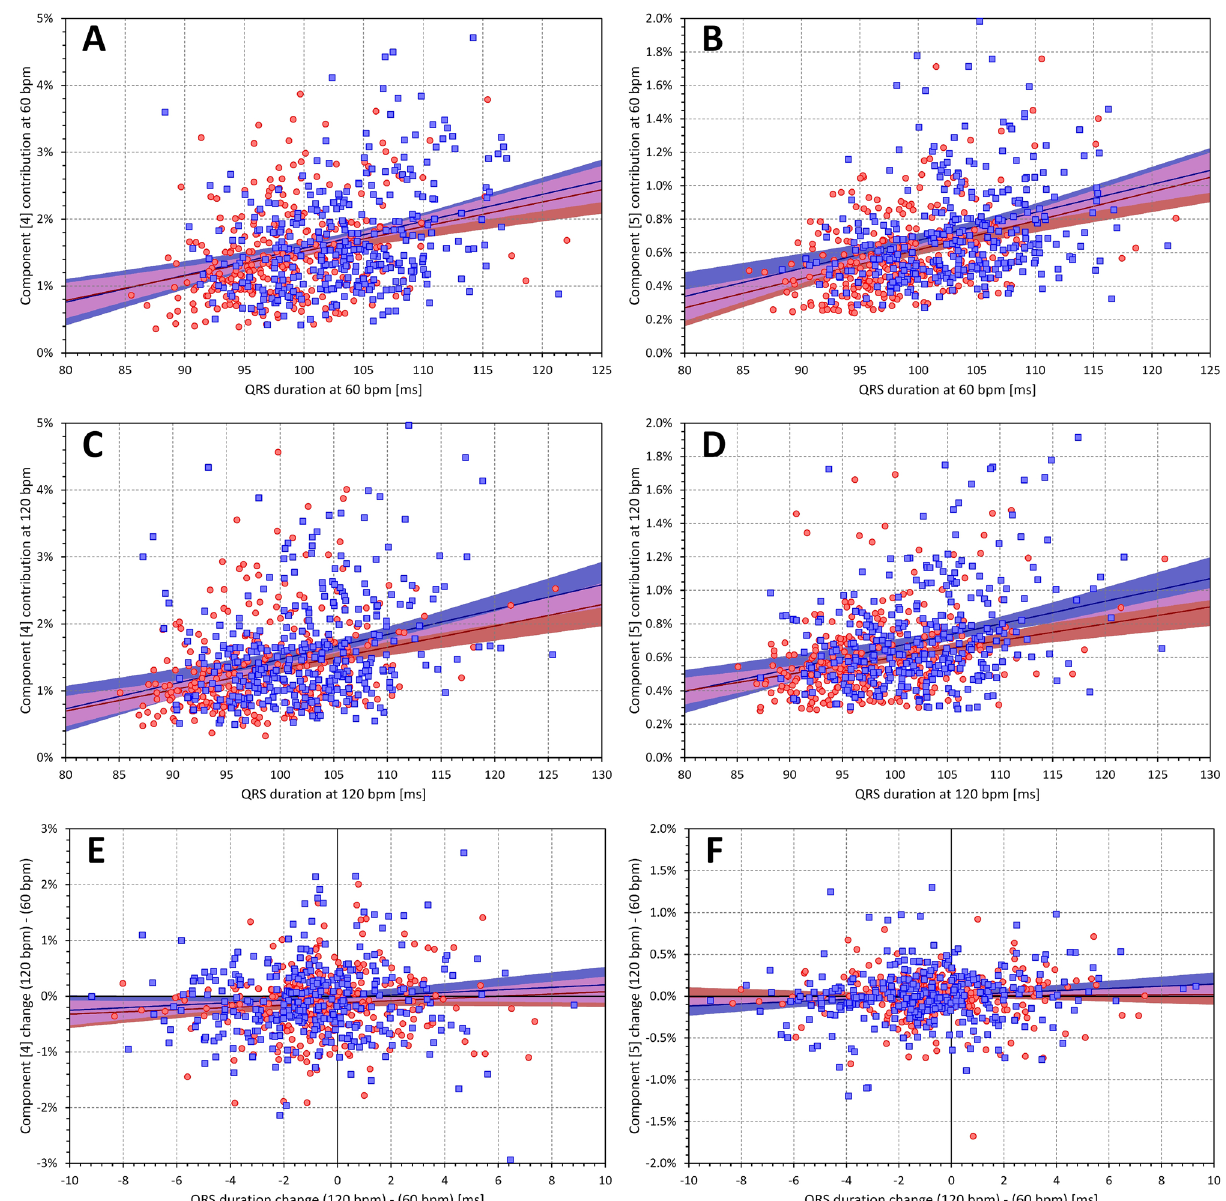
to QRS duration at heart rate of 60 and 120 bpm, respectively. The panel ( E ) shows the scatter diagram of the ∇ 4 changes between 120 and 60 bpm to the corresponding changes of QRS duration. The right panels B, D, and F show the same for component ∇ 5 . The meaning of the symbols in scatter diagrams is the same as in the scatter diagrams of Fig.